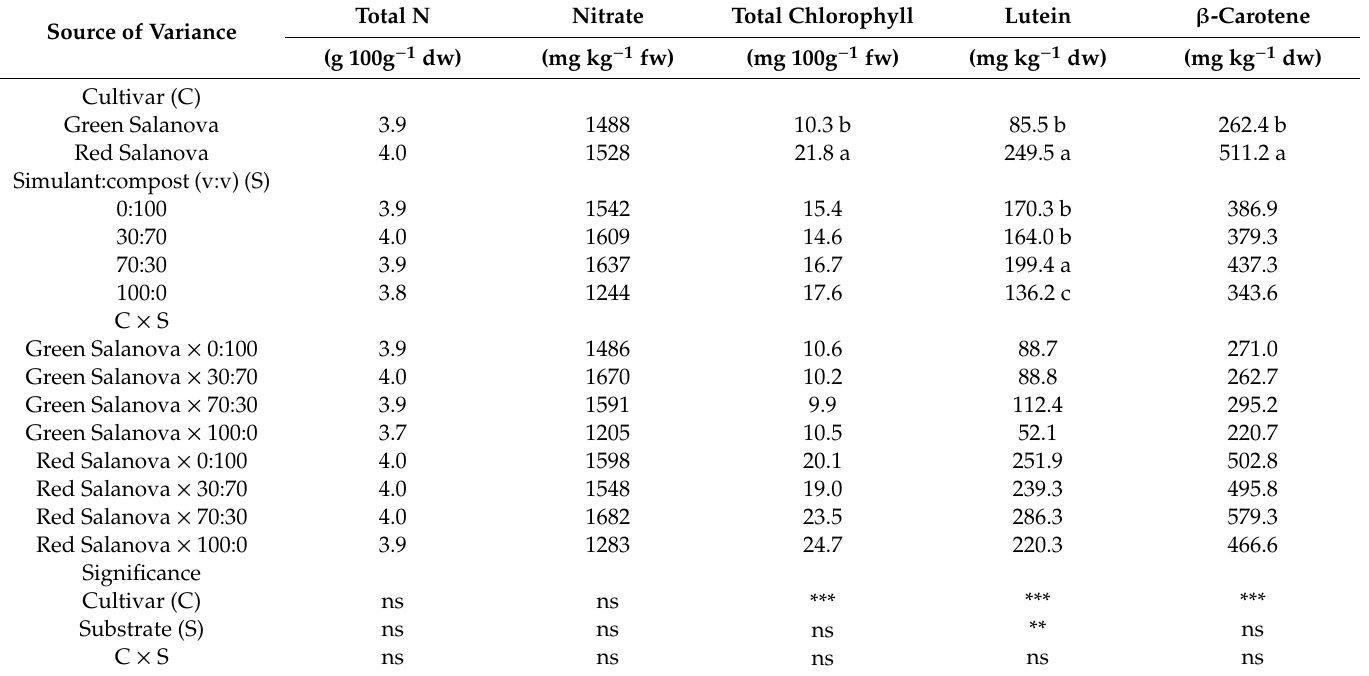
Table 2. Total nitrogen, nitrate, total chlorophyll, lutein and β -carotene of green and red Salanova lettuce as influenced by substrate mixture (four di ff erent rates of MMS-1 simulant:compost